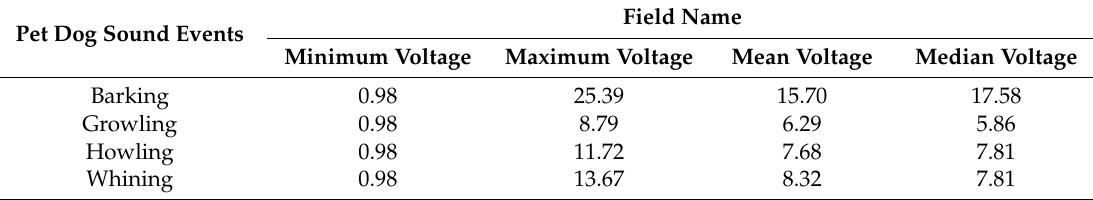
Table 4. Differences of voltage value according to each sound event of data extracted from sensor. Pet Dog Sound